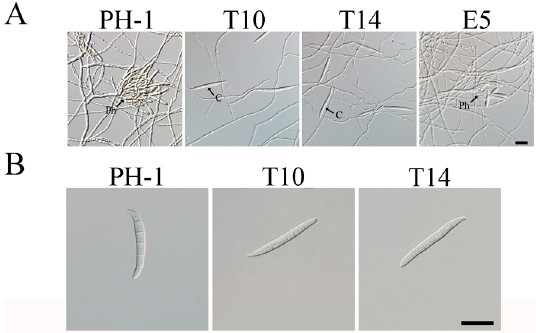
Figure 2. Conidiogenesis and conidium morphology defects of the Δ gil1 mutants. ( A ) Five-day-old CMC cultures of the wild type (PH-1), Δ gil1 mutants (T10 and T14), and ectopic strain (E5) were examined for conidiogenous structures. C, conidium; Ph, phialide. Bar = 10 µm; and ( B ) typical conidia of PH-1 and Δ gil1 mutants. Bar = 20 µm.